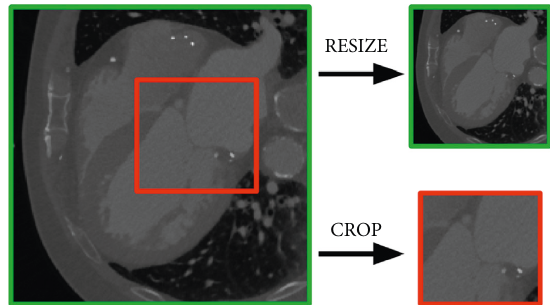
Figure 3: CT data can be resized (top right) or cropped (bottom right) depending on the application at hand. Resizing keeps the entire data but in a smaller format. Cropping takes out a region of interest without any resizing.